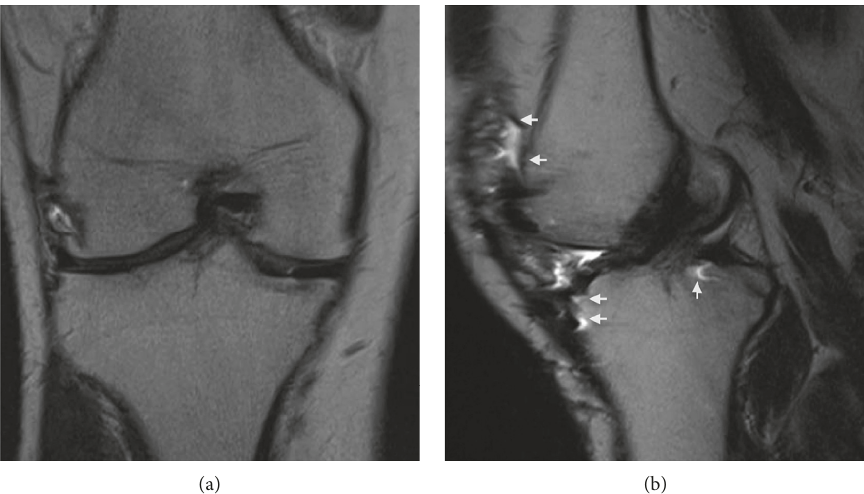
Figure 1: Coronal (a) and sagittal (b) T2-weighted metal reduction magnetic resonance images of the right knee, demonstrating an apparently intact ACL. Note the presence of metallic artifacts (white arrows) throughout the anterior and posterior aspect of the knee on the sagittal image.